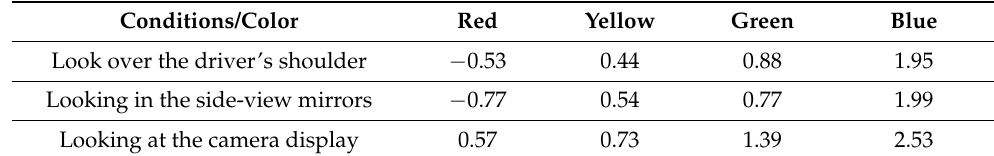
Table 2. The mean error of the estimation of the distance to the object.